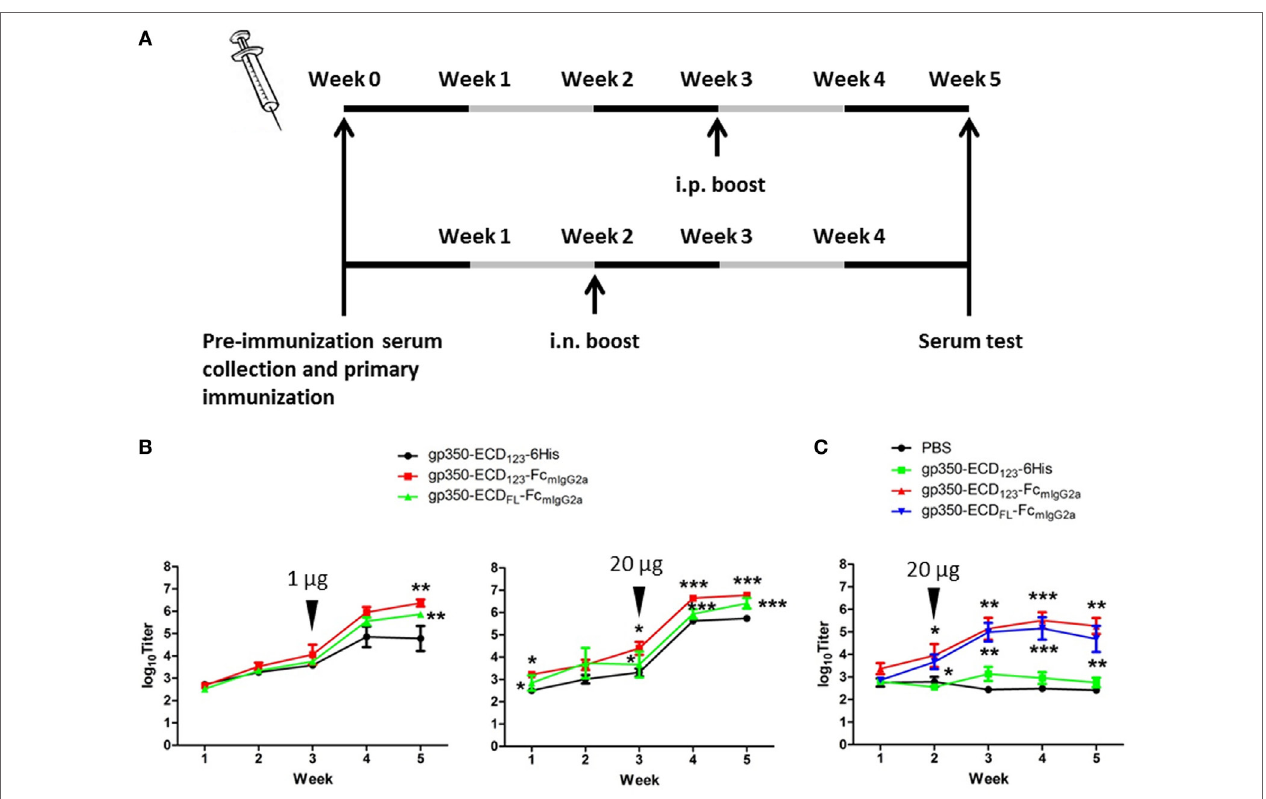
FigUre 3 | gp350 proteins fused with Fc mIgG2a domain were notably more immunogenic than monomers in the presence of adjuvants. (a) Diagram of the immunization protocols. Mice were boosted on week 2 for i.n. group or week 3 for i.p. group. (B) Mice (five per group) were immunized i.p. with 1 µg (left panel) or 20 µg (right panel) recombinant proteins in Imject Alum adjuvant. (c) Mice (five per group) were immunized i.n. with PBS or recombinant gp350 proteins mixed with CpG1826. Black arrowheads indicate the times of boosts. Each data point represents mean ± SEM ( n = 5). Significance (* p ≤ 0.05, ** p < 0.01, and *** p < 0.001) between Fc fusion proteins versus monomer gp350 proteins is